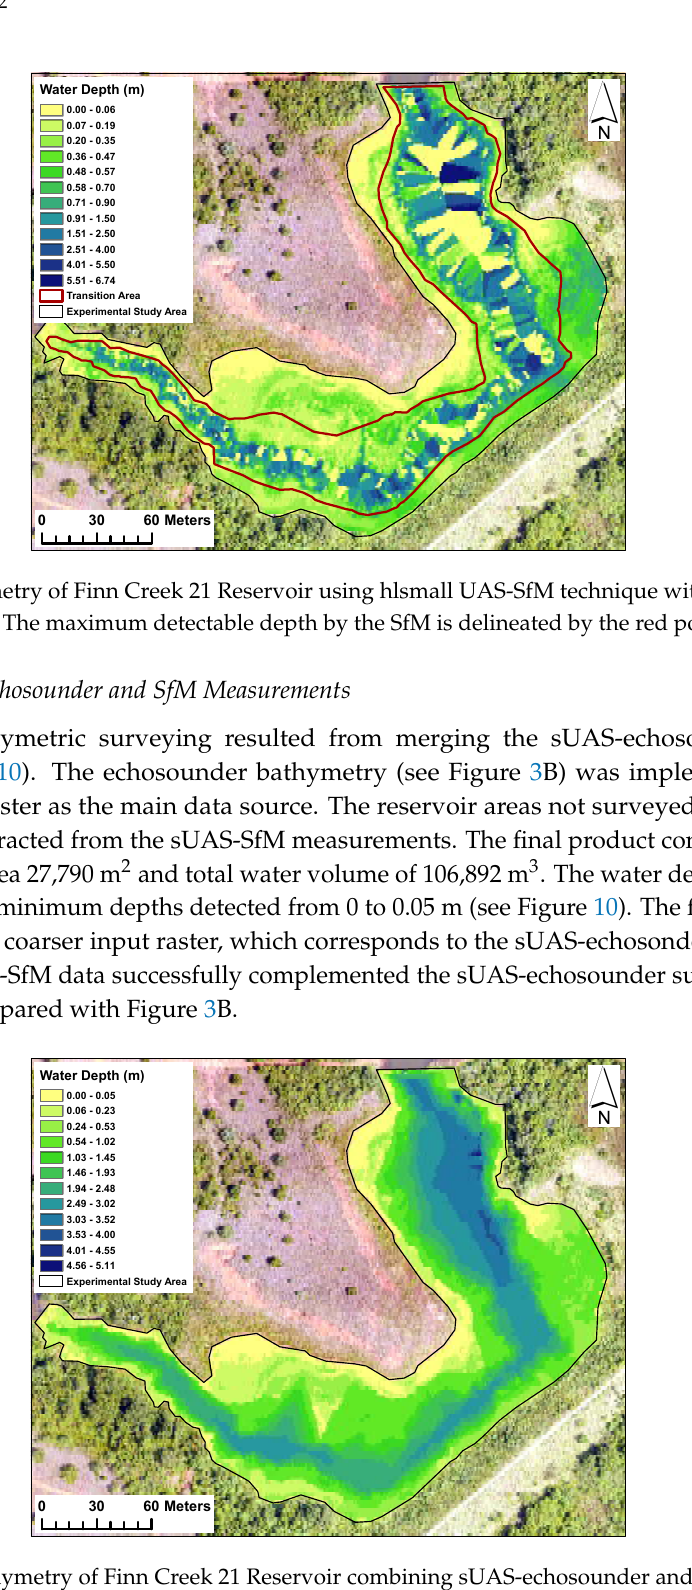
Figure 10. Bathymetry of Finn Creek 21 Reservoir combining sUAS-echosounder and